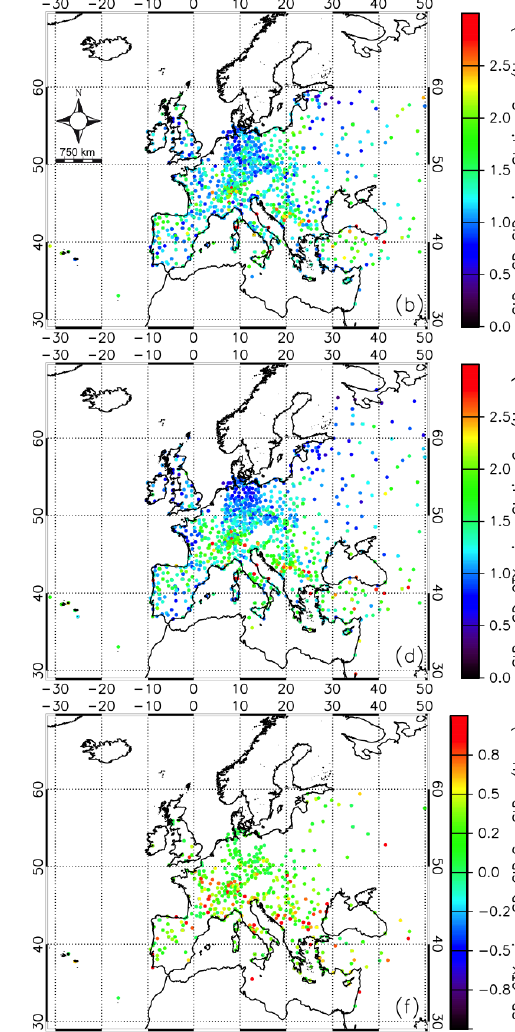
Figure 10. Maps showing ( a ) mean daily SD-SID minus station difference; ( b ) standard deviation of daily SD-SID minus station differences; ( c ) mean daily SD-CTY minus station difference; ( d ) standard deviation of daily SD-CTY minus station differences; ( e ) mean daily SD-CTY bias minus SD-SID bias ( i.e. , panel (c) minus panel (a)) and ( f ) mean daily SD-CTY standard deviation minus SD-SID standard deviation ( i.e. , panel (d) minus panel (b)) at each station for January